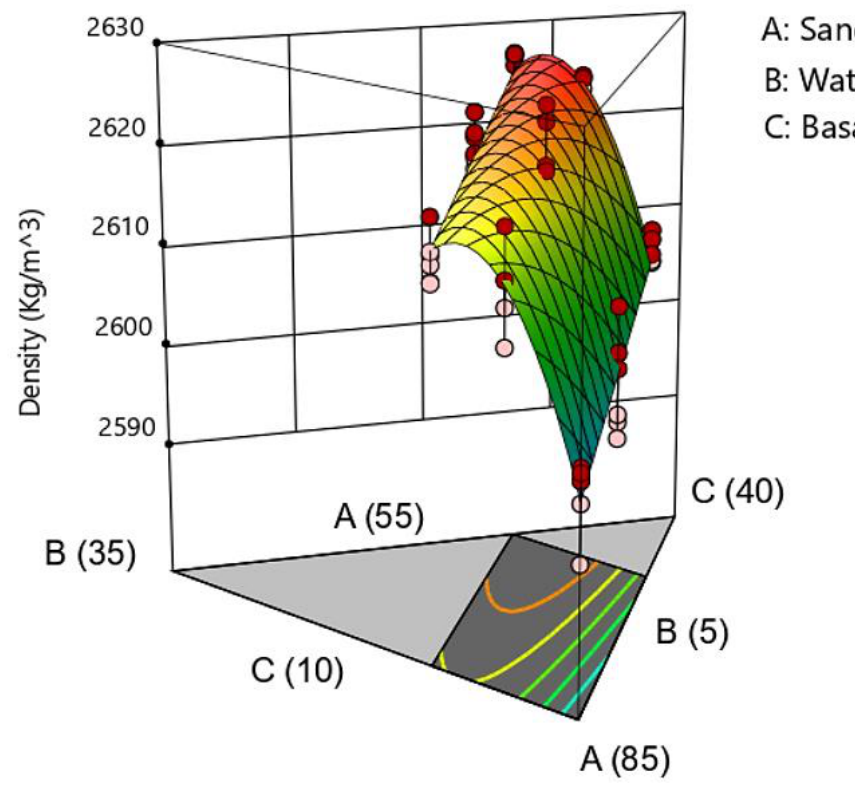
Figure 10. Density of samples.